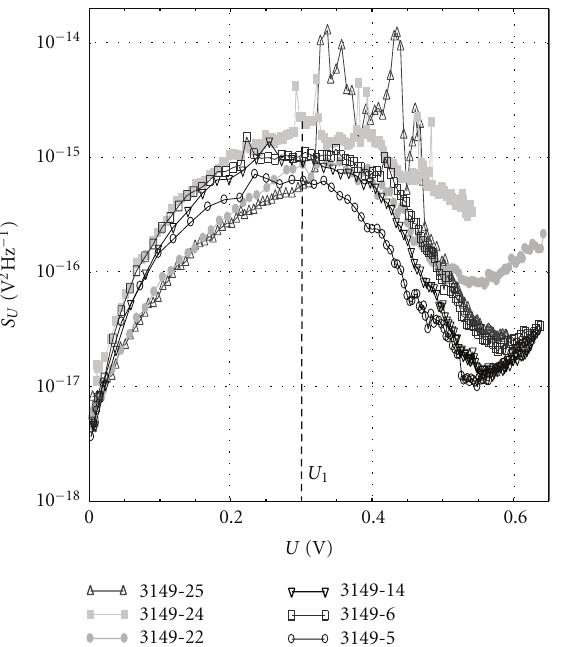
Figure 2: The noise spectral density as a function of forward voltage for group of samples 3149.